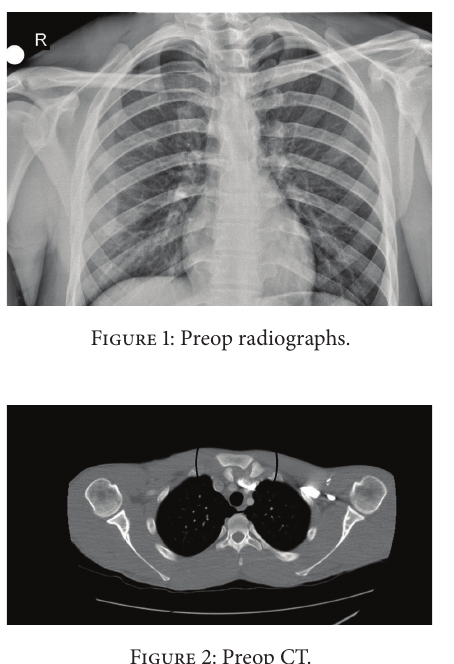
Figure 2: Preop CT.